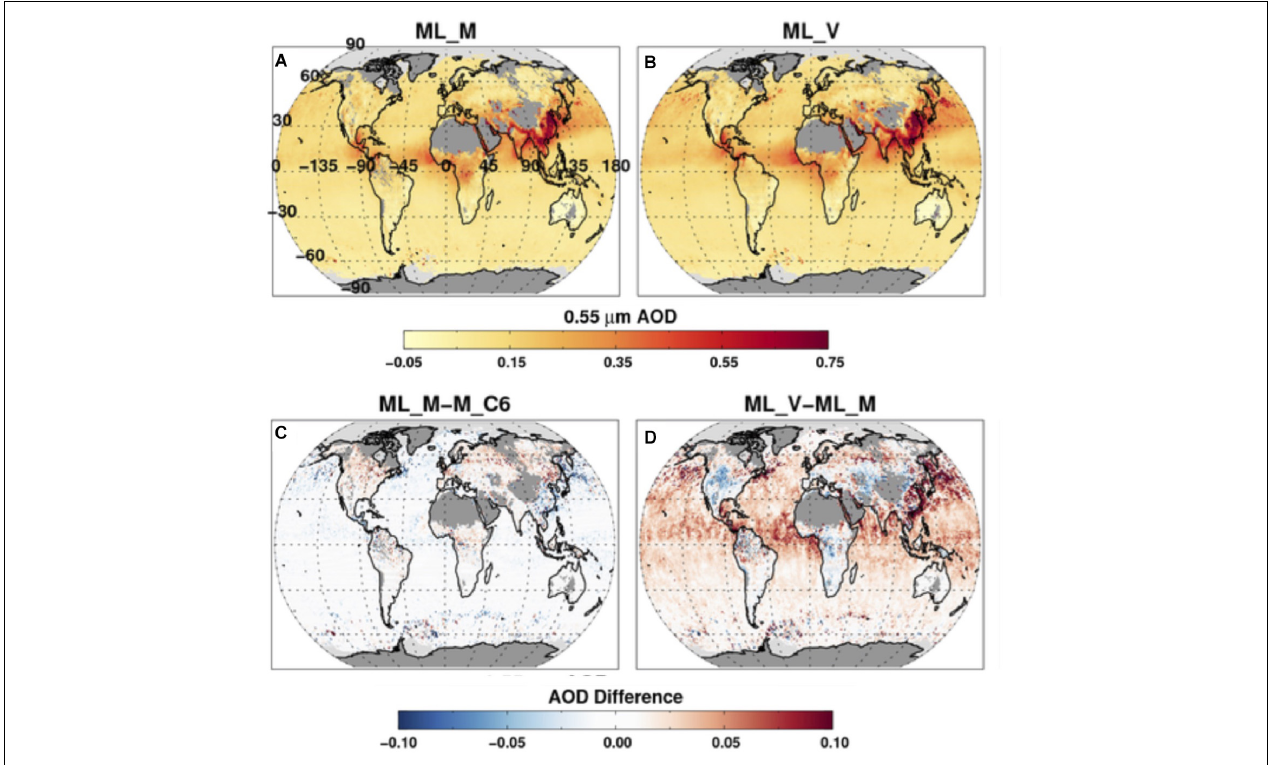
FIGURE 1 | (A,B) Global seasonal mean AOD at 550 nm (March–April–May) as derived from the MODIS-like retrieval algorithm applied to MODIS input radiances (A) and applied to VIIRS input radiances (B) . (C) Difference between (A) and the corresponding seasonal mean AOD at 550 nm produced from the operational